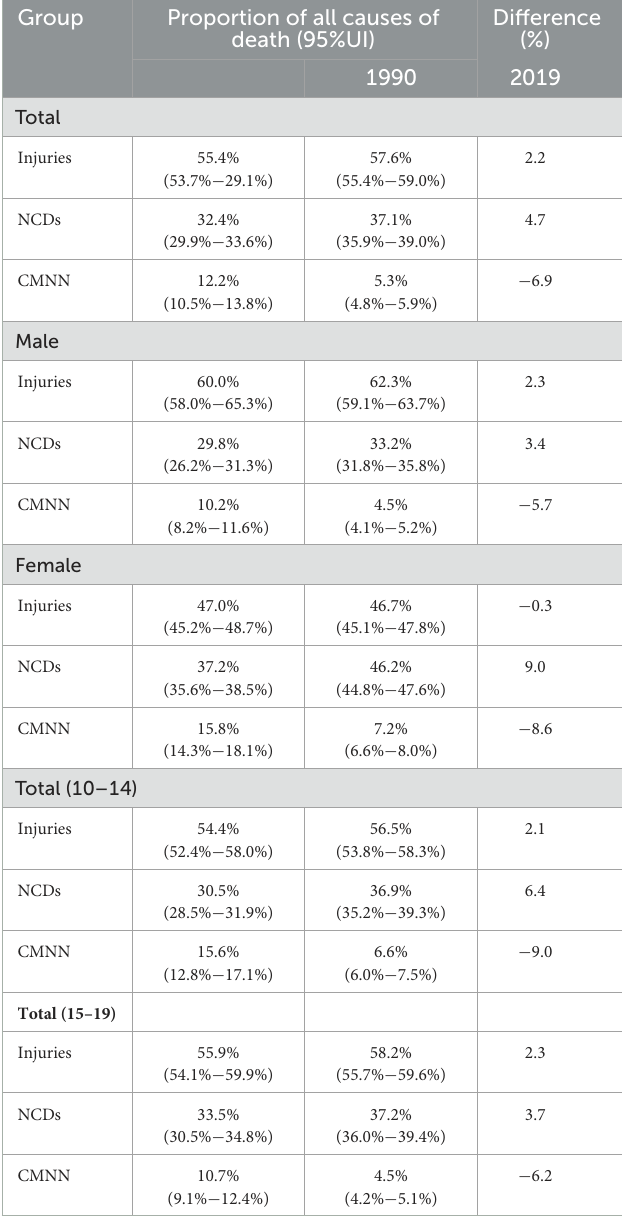
TABLE 2 The proportion for three categories of adolescents aged 10–19 years in China, 1990 and 2019. Group Proportion of all causes of Difference death (95%UI)